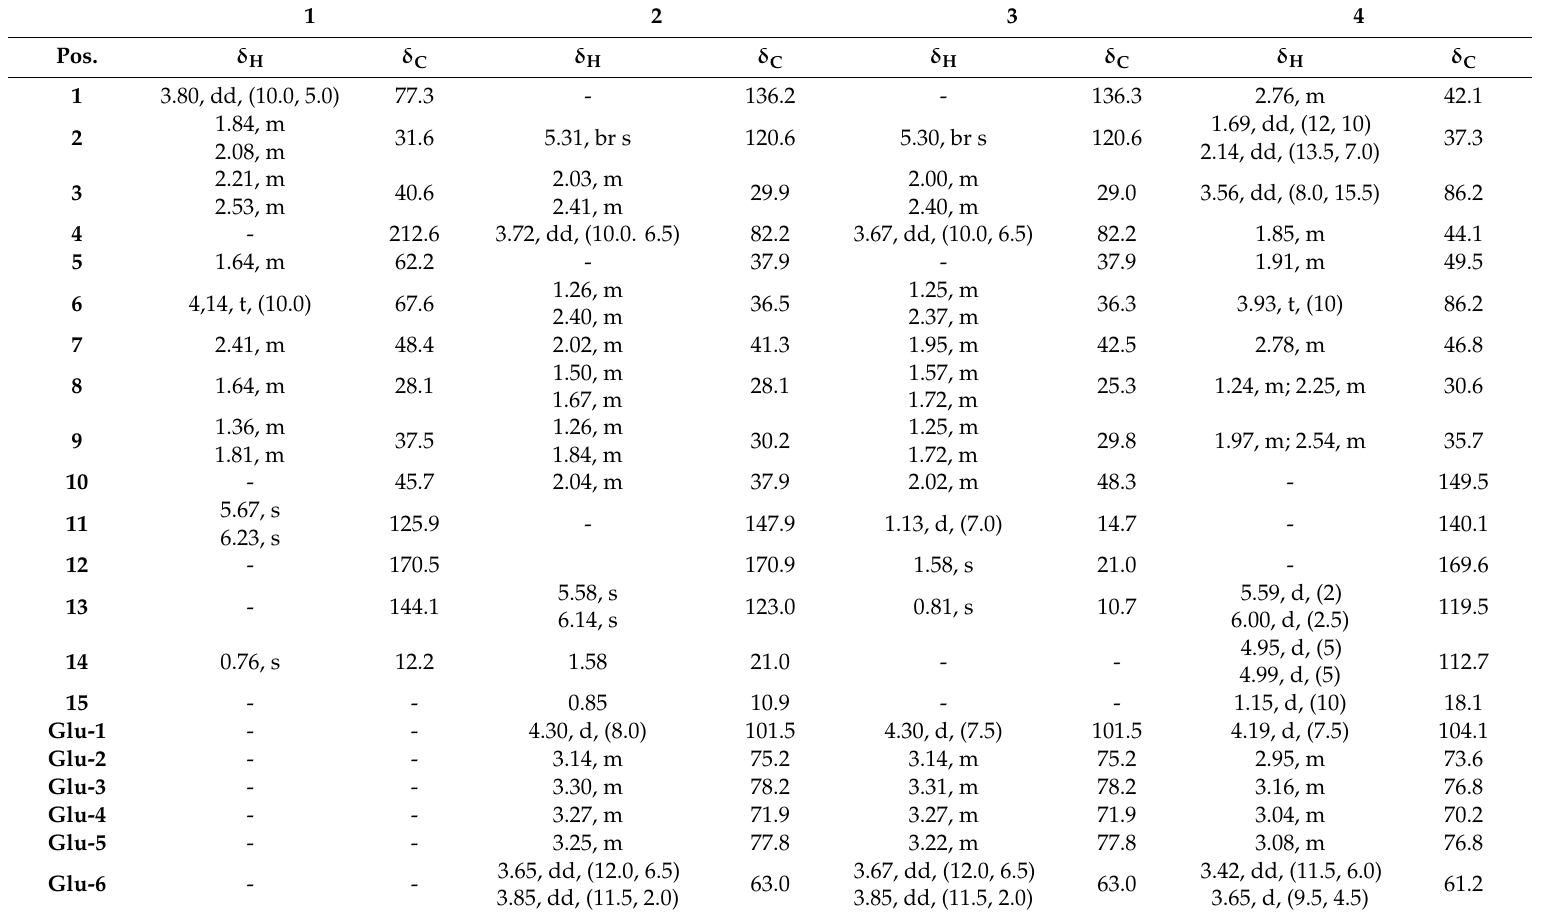
Table 1. 1 H and 13 C-NMR spectral data for compounds 1 – 4